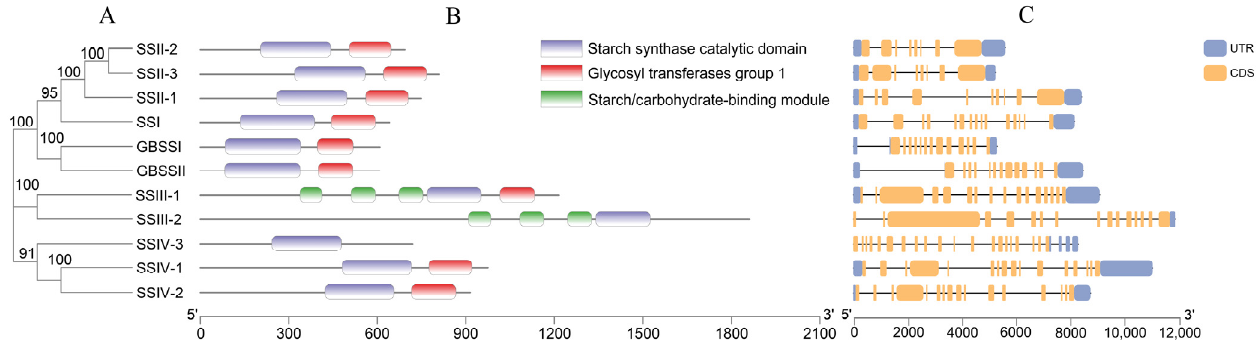
Figure 3. The OsSS gene family structure based on a phylogenetic tree. ( A ) Phylogenetic relationship of OsSS; ( B ) prediction of domain structure; and ( C ) gene structure. The numbers below A and B represent the length of the amino acid (aa) and target sequence (bp),